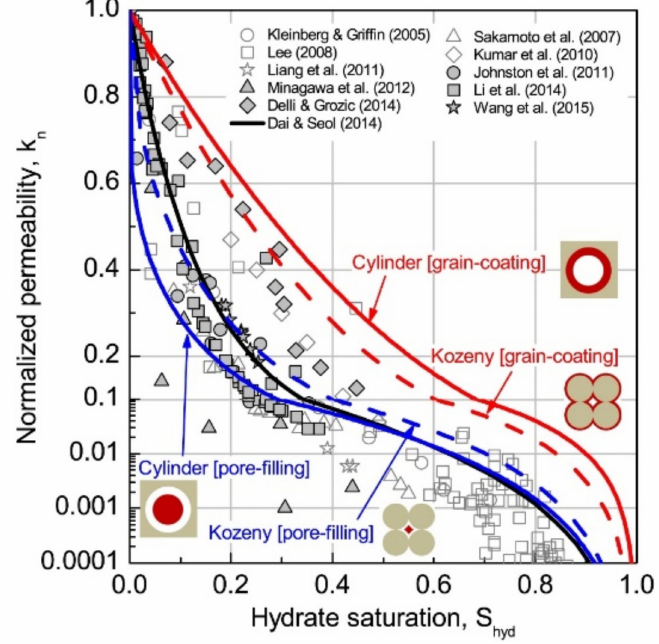
Figure 6. Comparison of experimental data [24,82,89,92–98] and prediction results [23,40] due to hydrate growth. Reprinted with permission from Ref. [53]. Copyright 2022 American Geophysi- cal